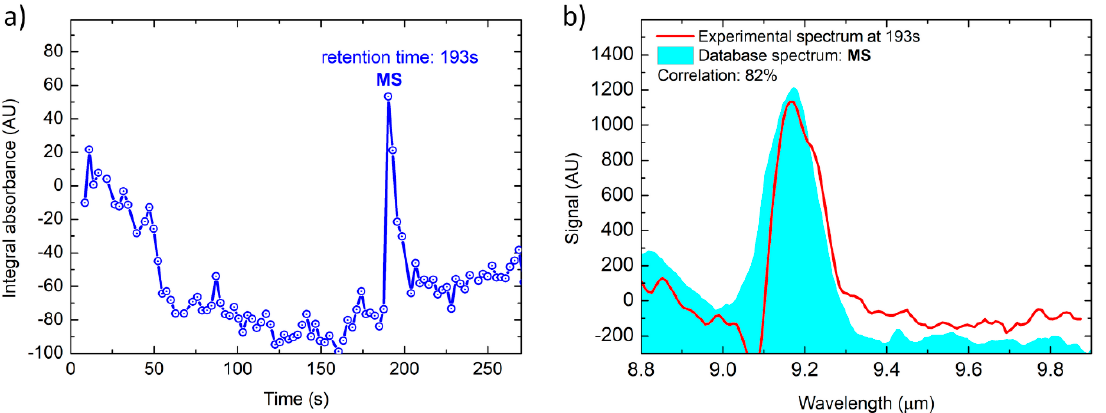
Figure 9. Total absorption chromatogram ( a ) and MS spectrum acquired at T = 193 s compared with the library spectrum ( b ).